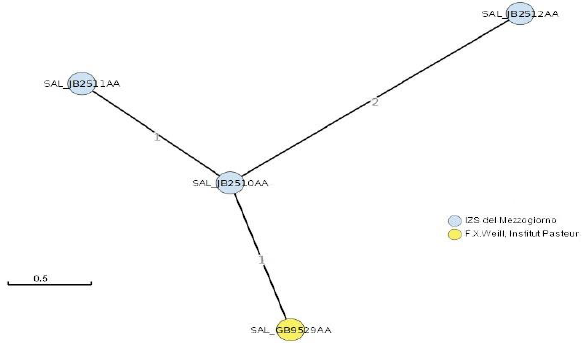
Figure 1. Minimum spanning tree (MST) based on cgMLST. In blue are highlighted SAL_JB2510AA, SAL_JB2511AA, SAL_JB2512AA isolates (respectively corresponding to 96582/19, 101102/19 and 38020/20), while in yellowSAL_GB9529AA isolate (deposited by Institute Pasteur). Numbers on branches indicate the allelic distance (AD) among connected isolates.